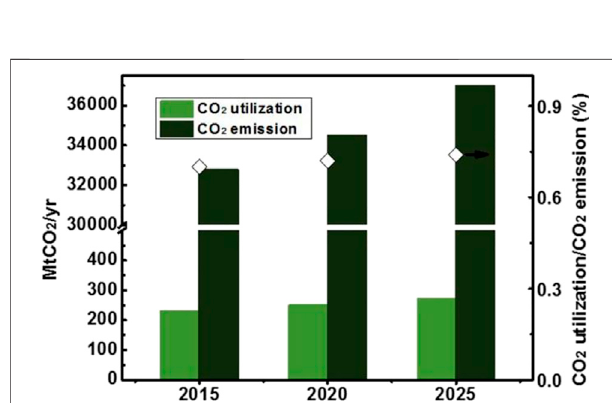
FIGURE 1 | (A) Schematic diagram of the energy budget of the earth: the yellow arrows are the short wave radiation re fl ected and absorbed by the earth; the red arrows are the long wave radiation absorbed by greenhouse gases and released from the earth. Figure from: https://science-u.org/experiments/solar-oven-smores. html. (B) Changes of atmospheric CO 2 concentration in the past 800,000 years. Figure from: Scripps Institute of Oceanography, https://sioweb.ucsd.edu/programs/ keelingcurve/.